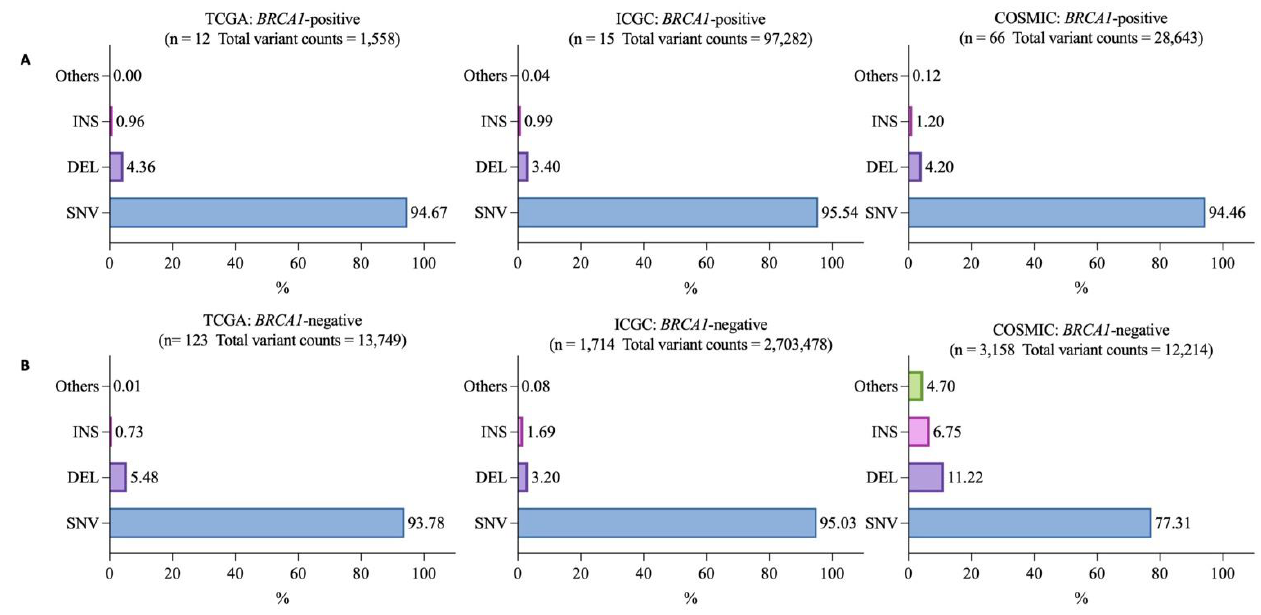
Figure 1. Percent variant type per total variant count in ( A ) BRCA1 -positive and ( B ) BRCA1 -negative breast cancer samples shown by each database. Numbers on the bar graphs indicate the percentage of variant type per total variant count. (INS = insertion, DEL = deletion, SNV = single nucleotide variant).